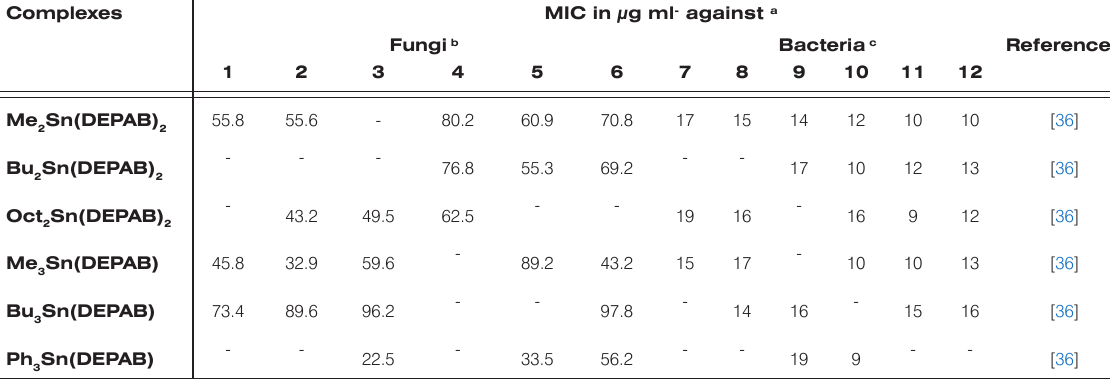
Table 4. Results of antimicrobial activity of organotin(IV) carboxylates.